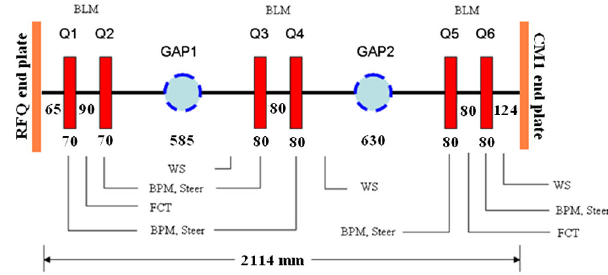
FIG. 6. The schematic of Injector I